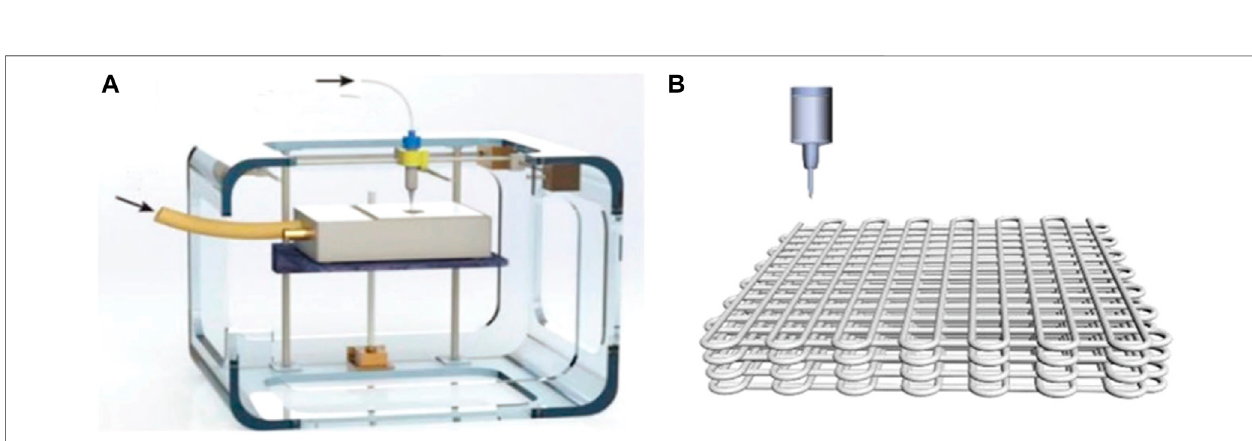
Frontiers in Chemistry |